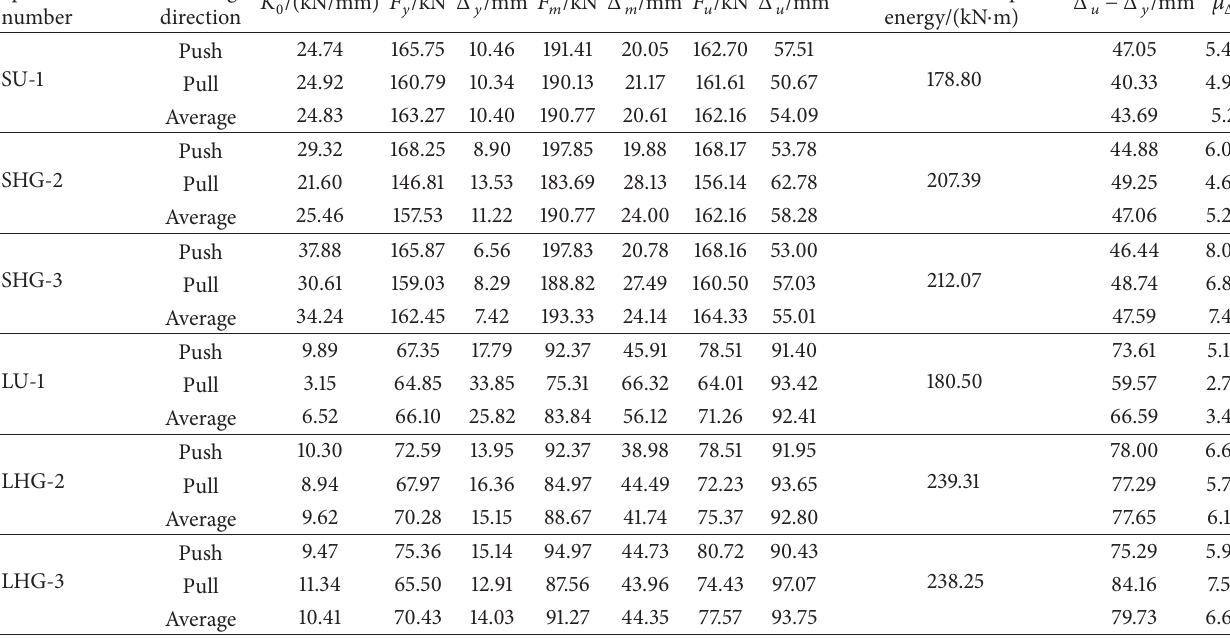
Table 4: Experimental results.